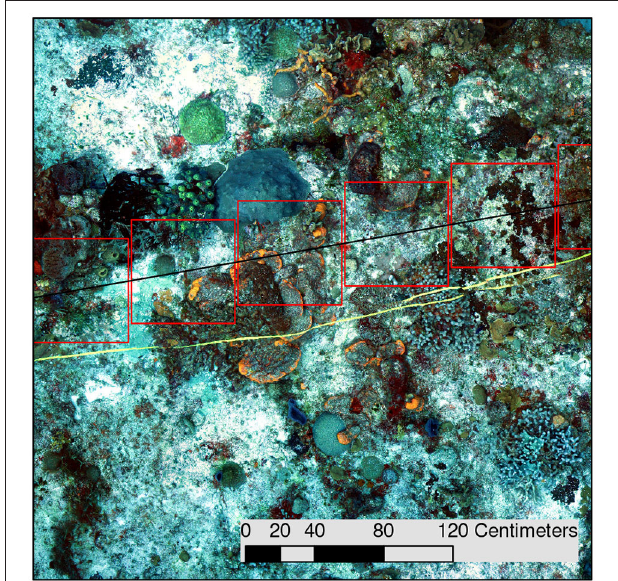
FIGURE 3 | Example of a simulated video transect. The black line is a polyline resembling a transect over the orthomosaic. Each red box represents an extracted frame. The yellow line is the original transect.